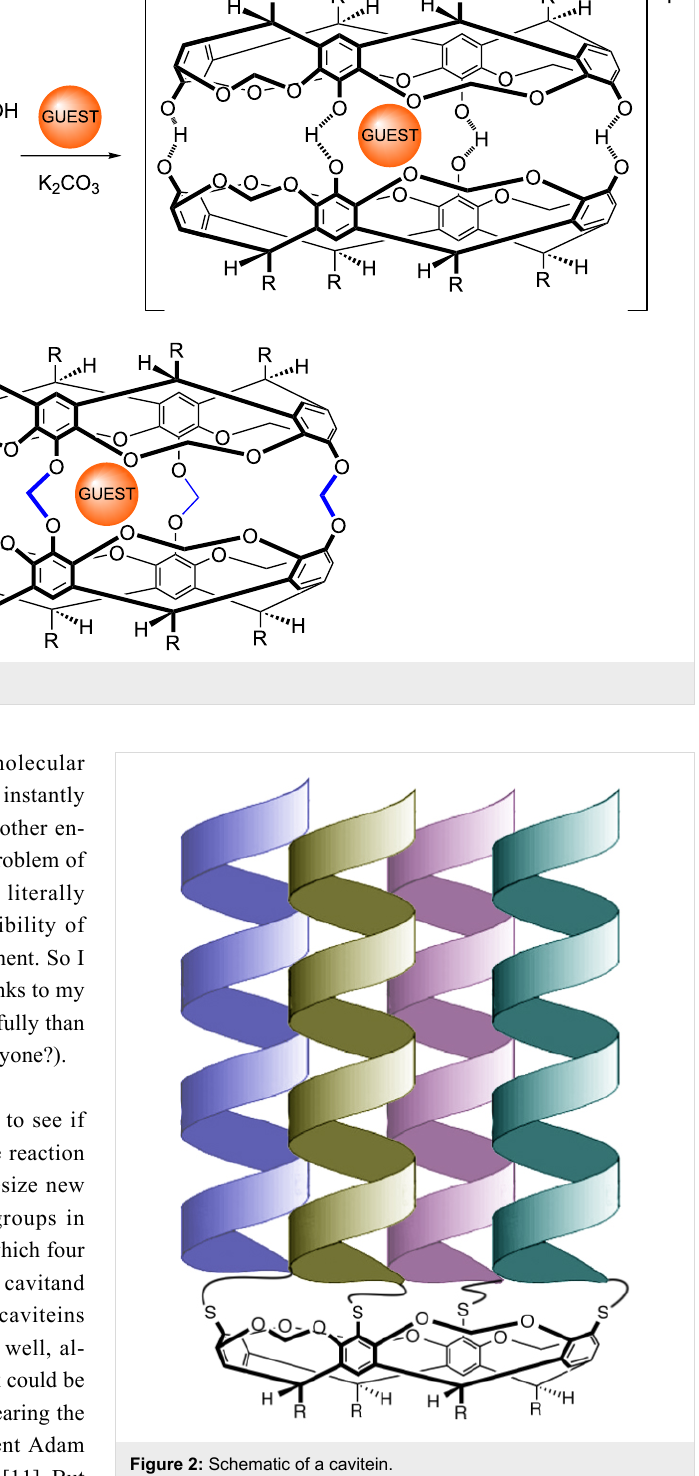
Figure 2: Schematic of a